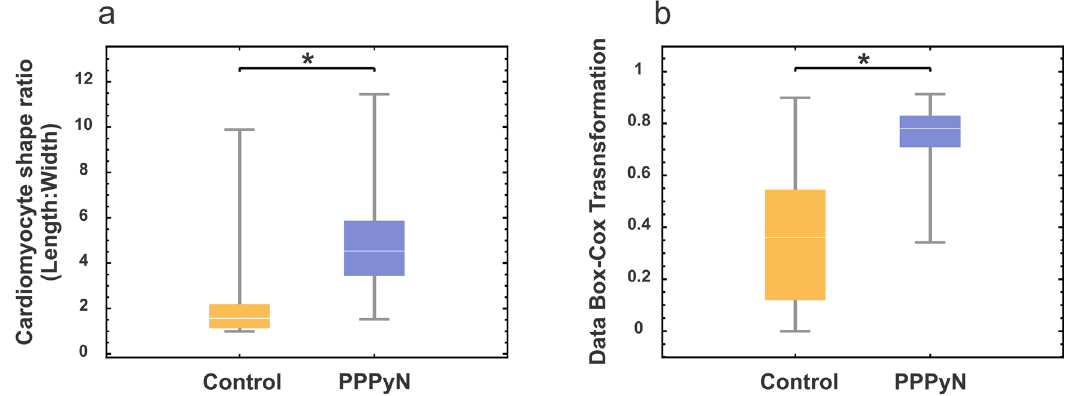
Fig. 7 a ARVC shape ratio ( R L:W ) boxplots, control and PPPyN groups. b Boxplots after Box – Cox transformation